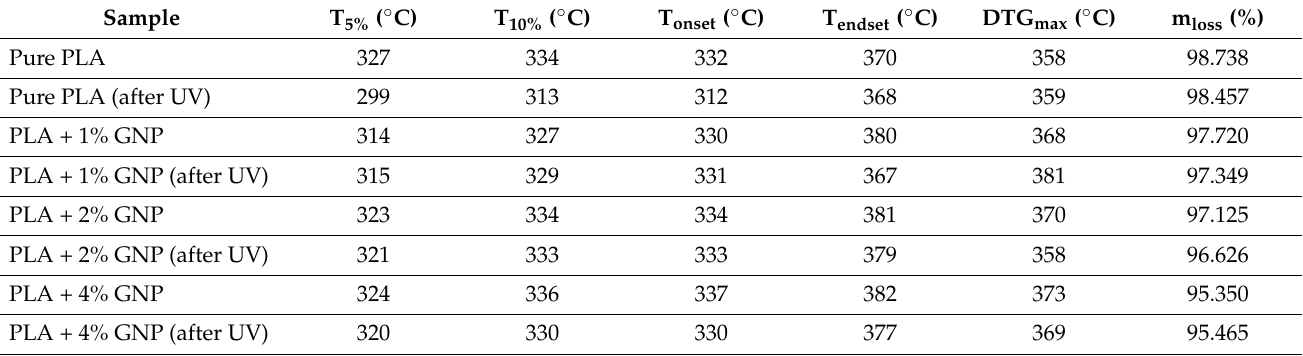
Table 2. Weight loss for PLA samples and PLA/graphene